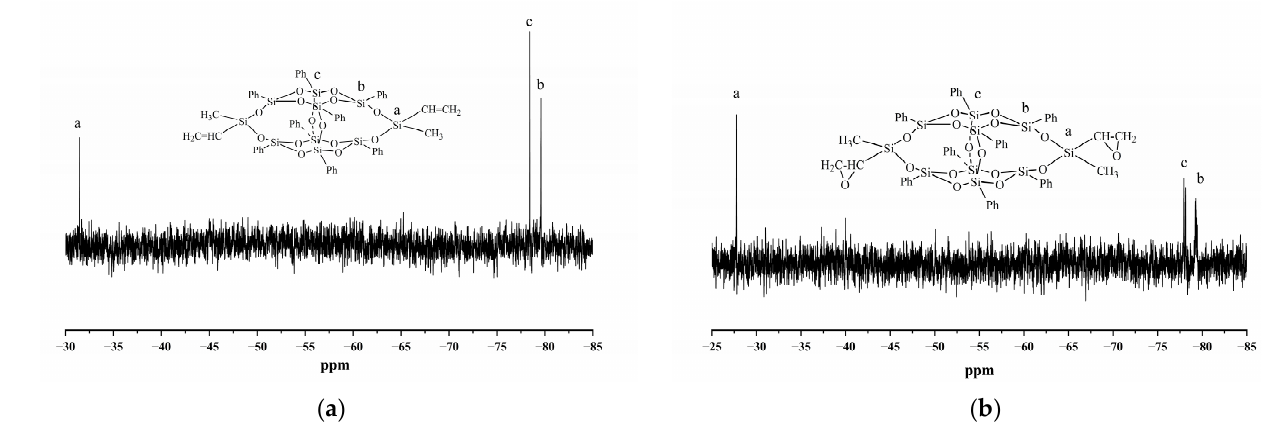
Figure 4. 1 H-NMR spectra of ( a ) DDSQ-VS and ( b ) DDSQ-EP. Demonstrated in Figure 5 are the 29 Si NMR spectra of DDSQ-VS and DDSQ-EP. As it can be seen that both of them have three main signal peaks. For DDSQ-VS, the chemical shift at − 31.45 ppm is the silicon atom connecting the vinyl, methyl and cage skeletons. After the epoxidation of the vinyl group, the chemical shift of the silicon atom changes to a higher position, correspondingly at − 27.76 ppm in the DDSQ-EP spectrum whereas the peaks at − 78.42 ppm and − 79.58 ppm are assignable to the chemical shift of silicon atoms in the POSS skeleton, the position before and after the reaction is basically unchanged.